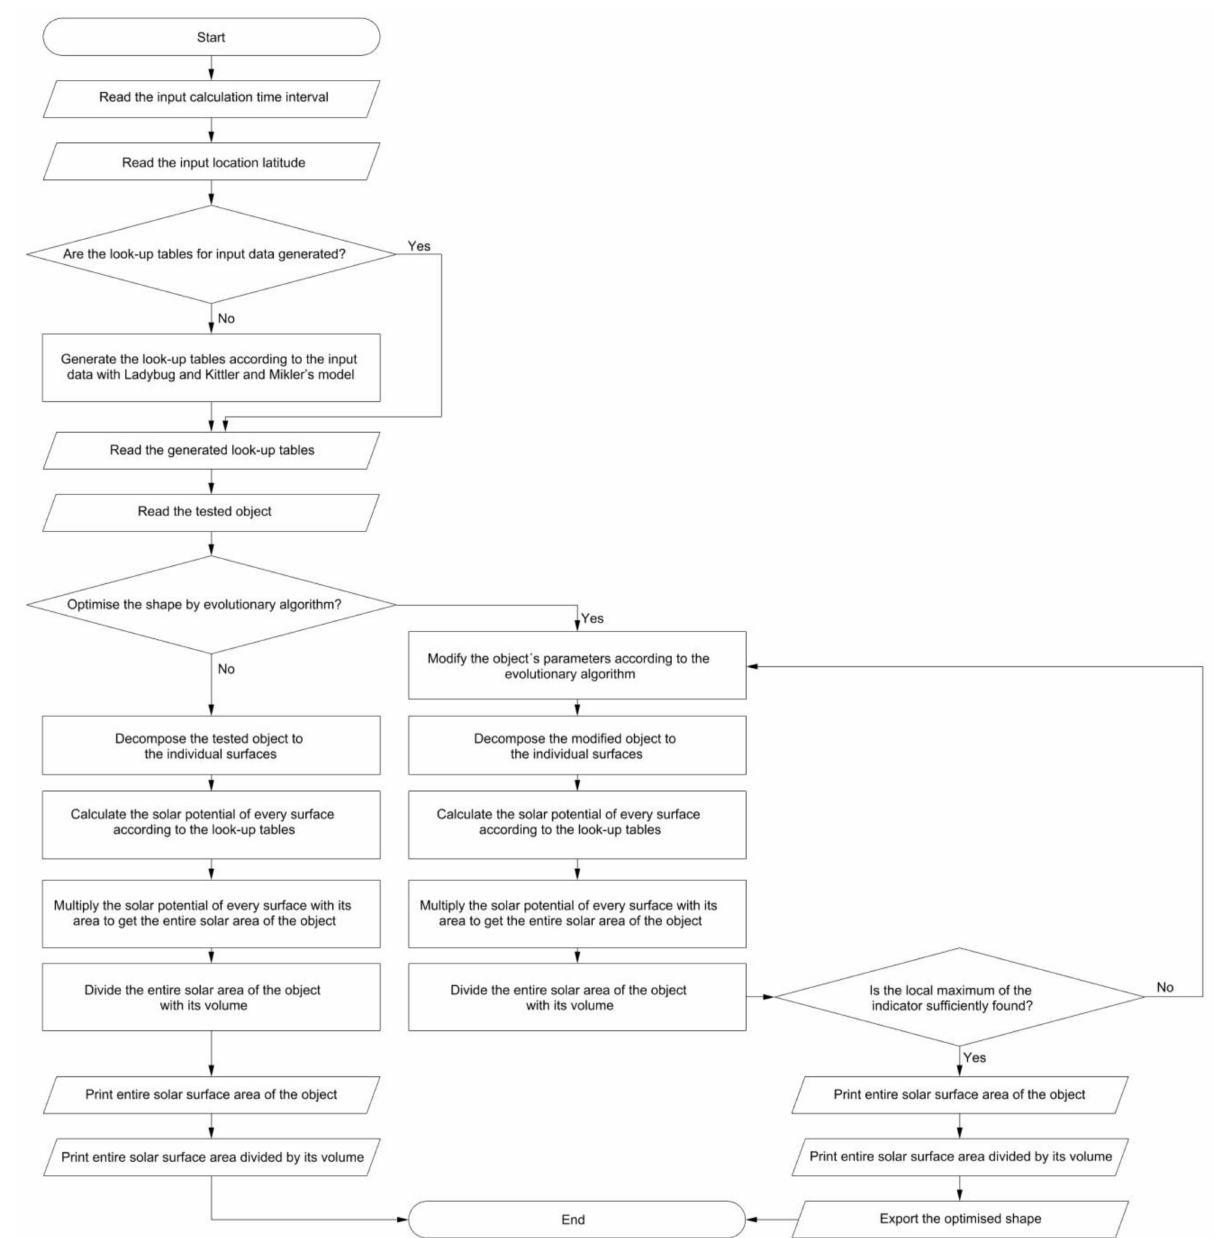
Figure 3. The algorithm for solar-surface-area-to-volume ratio. The algorithm without the evolution- ary optimisation part was also scripted in Javascript to help the public calculate and visualise the solar surface area and solar-surface-area-to-volume ratio